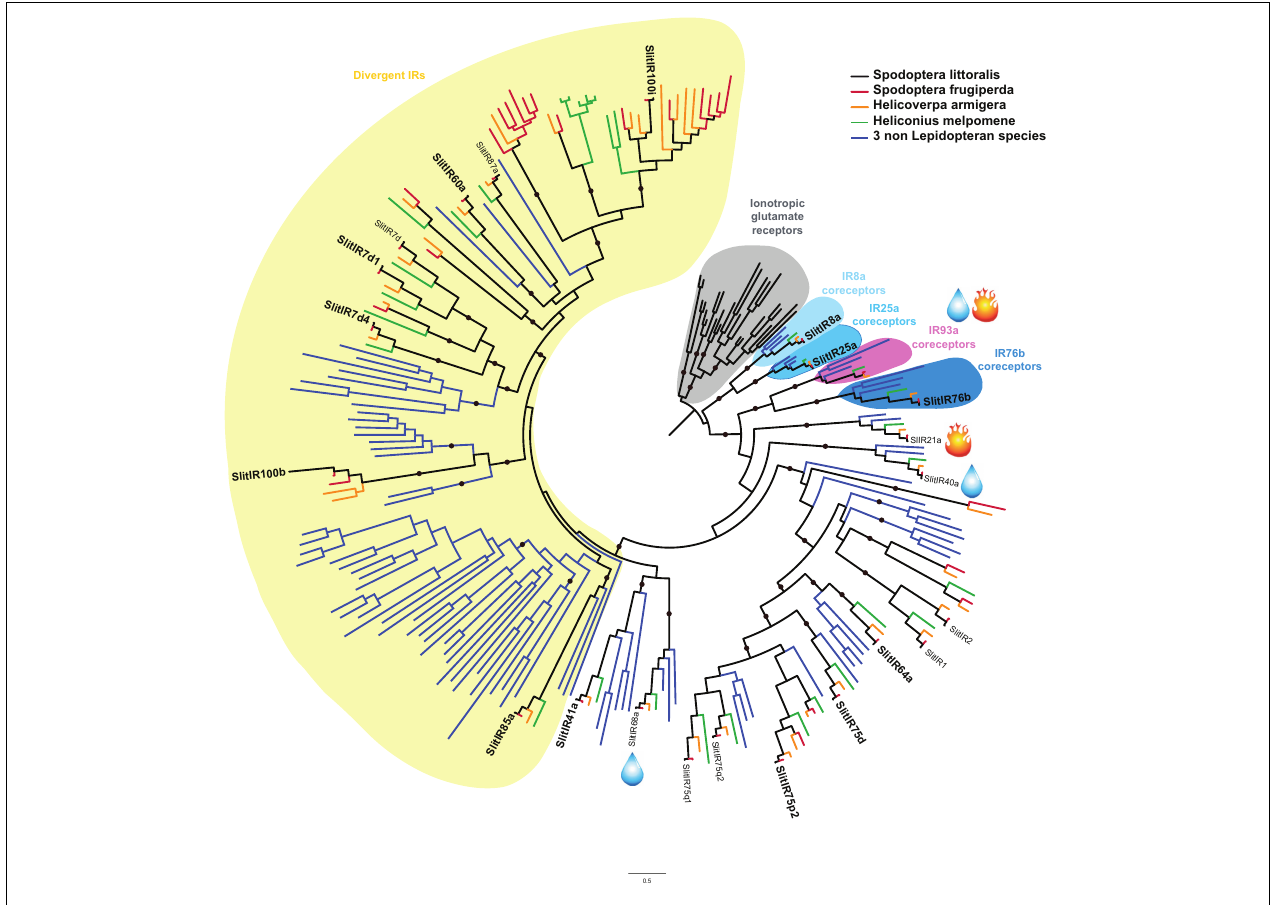
FIGURE 4 | Phylogenetic position of S. littoralis ionotropic receptors (SlitIRX, black). The phylogeny was built using IR repertoires of the moths S. frugiperda (red), H. armigera (yellow) and the butterfly H. melpomene (green), and three non-Lepidoptera species (blue): Drosophila melanogaster , Apis melifera, and Tribolium castaneum . SlitIRs found in the present transcriptome are written in bold. Three coreceptor clades are pictured with blue color shades and the coreceptor IR93a for hygro- and thermosensation is pink shaded. The ionotropic glutamate receptor clade is shaded in gray and was used as an outgroup. Candidate ionotropic receptors for hygrosensation and thermosensation according to their homology with Drosophila IRs are designated with the accolade of a self-explaining pictogram. Clades supported by an aLRT value over 0.9 are indicated by a black dot.